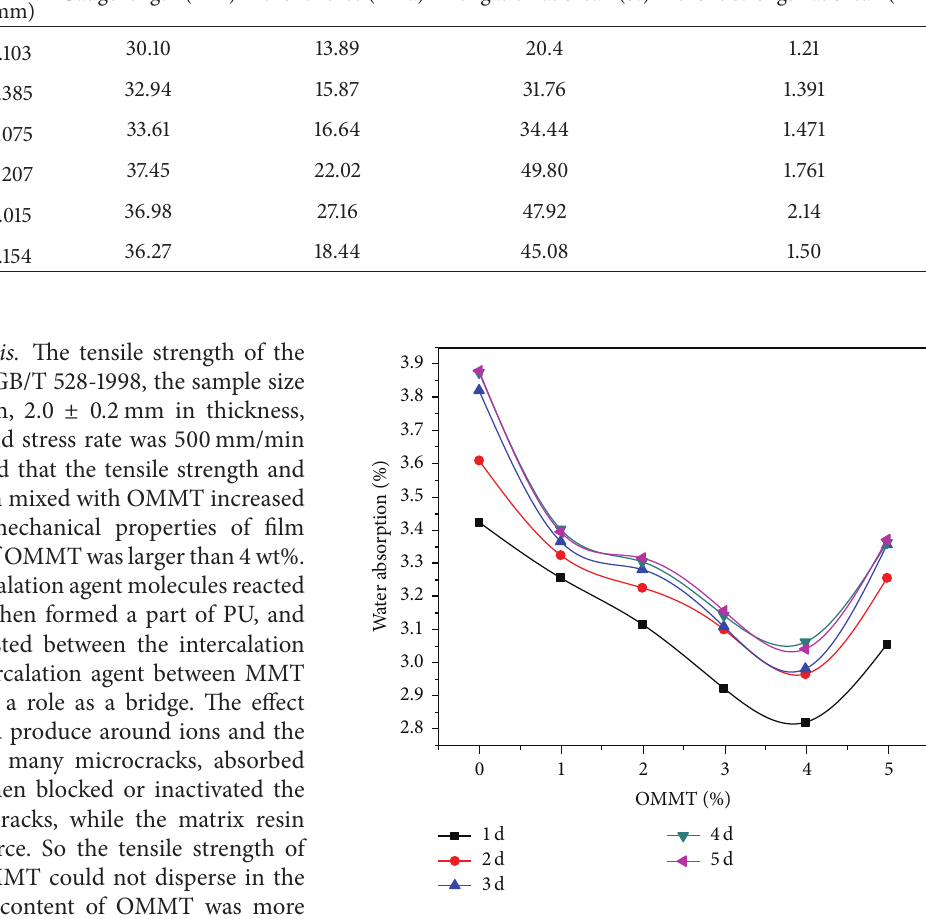
Figure 8: Water absorption curves of